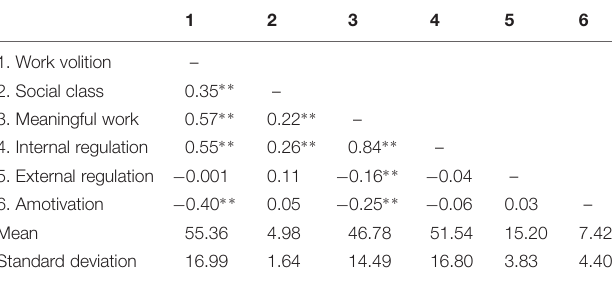
TABLE 1 | Descriptive statistics and factor correlations of study